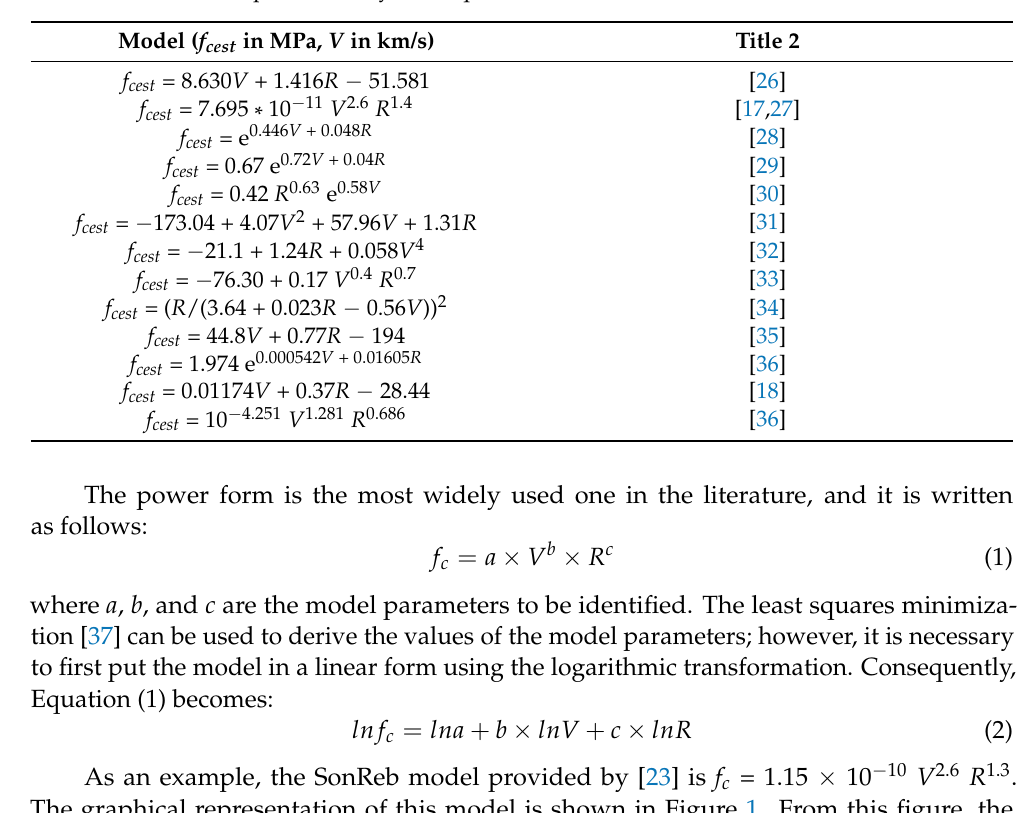
Table 1. Some models derived by different researchers in order to estimate strength using combined rebound hammer and pulse velocity